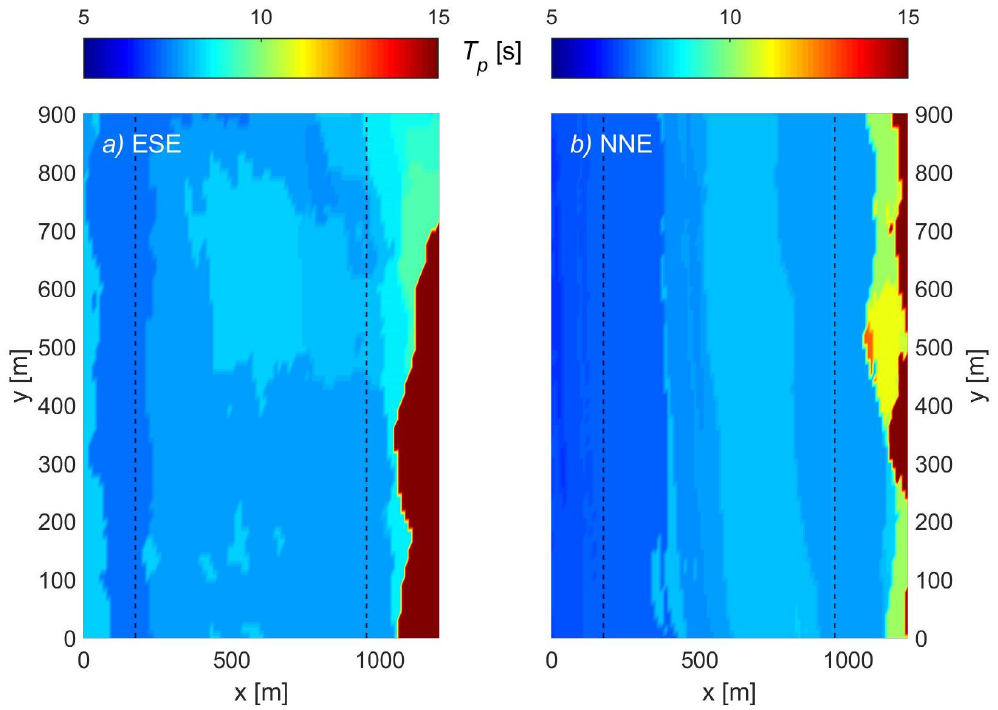
Figure 7. Reconstructed peak periods: ( a ) ESE and ( b ) NNE simulations. Dashed lines indicate the locations at which the boundary conditions are